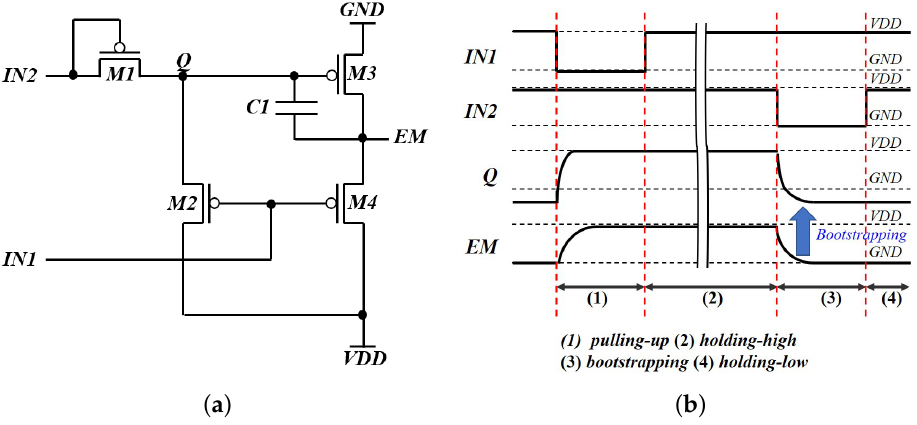
Figure 6. Proposed emission ( EM ) Circuit: ( a ) schematic where IN1 and IN2 are the last output of the previous shift register and the first output of the next one, respectively; and ( b ) timing